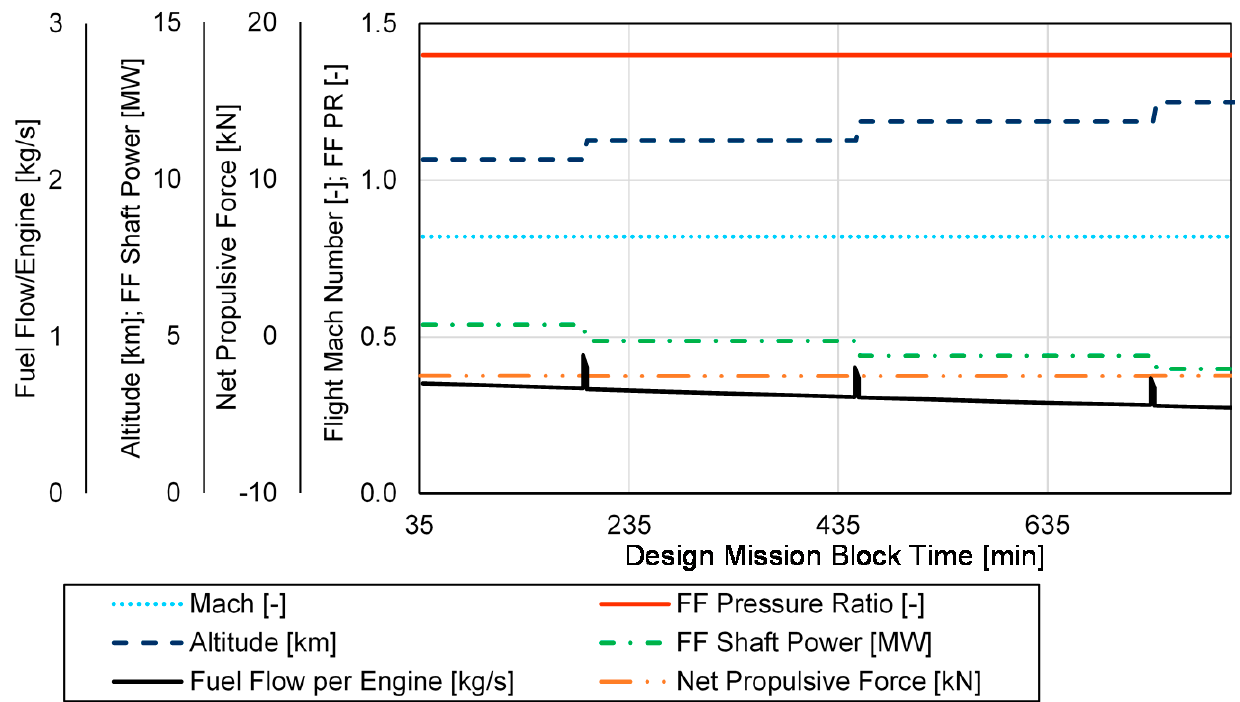
Figure 35. Simulated PFC aircraft specific performance characteristics recorded for the design mission cruise phase (adapted from [69]).